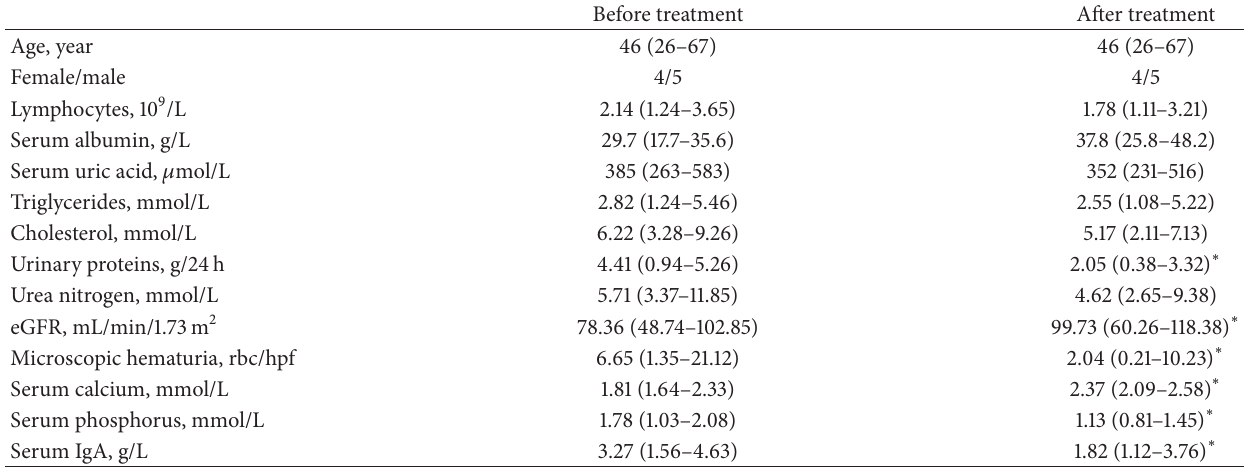
Table 2: Effect of treatment on the values of clinical measures in follow-up IgAN patients.